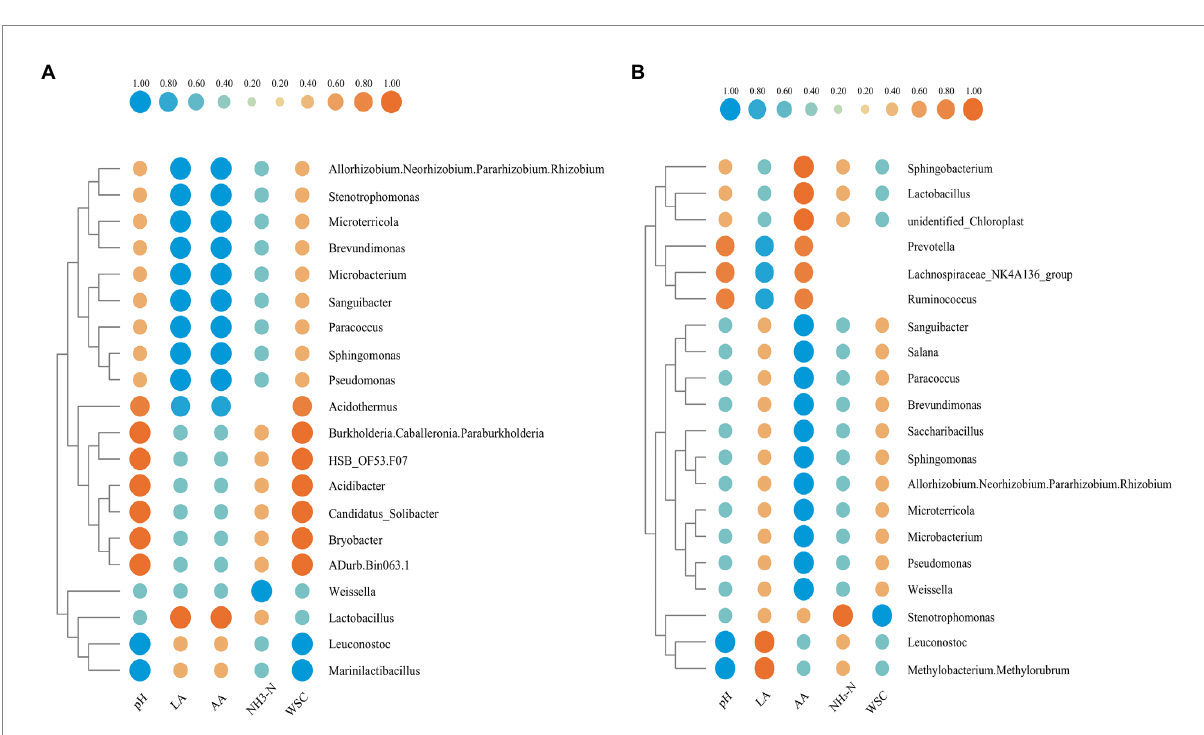
FIGURE 8 Spearman’s correlation heatmap of oat silaged at 20 ° C (A) and freeze–thaw condition (B)